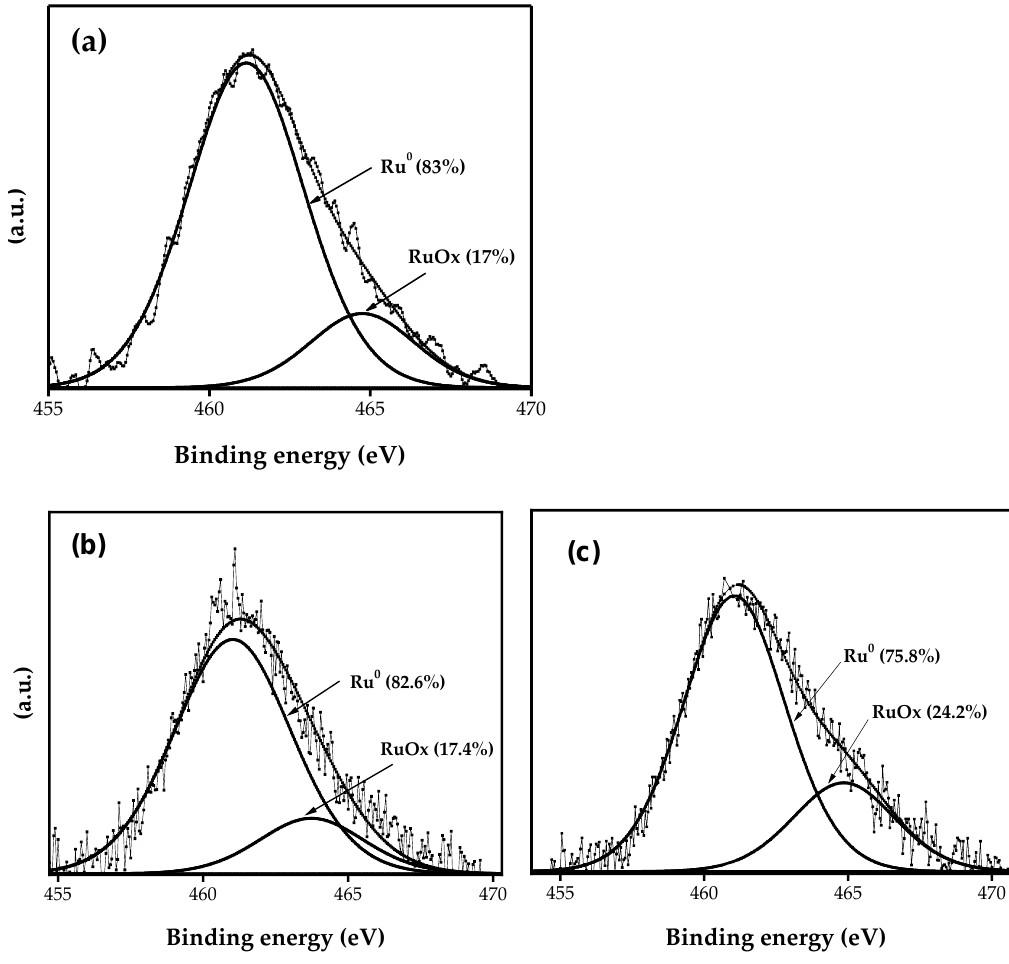
Figure 3. Ru3p 3/2 XPS signals for Ru/Al 2 O 3 ( a ), Ru/Al 2 O 3 -Ca(1 wt%) ( b ), and Ru/Al 2 O 3 -K(1 wt%); ( c ) catalysts, indicating the percentage of reduced and oxidized